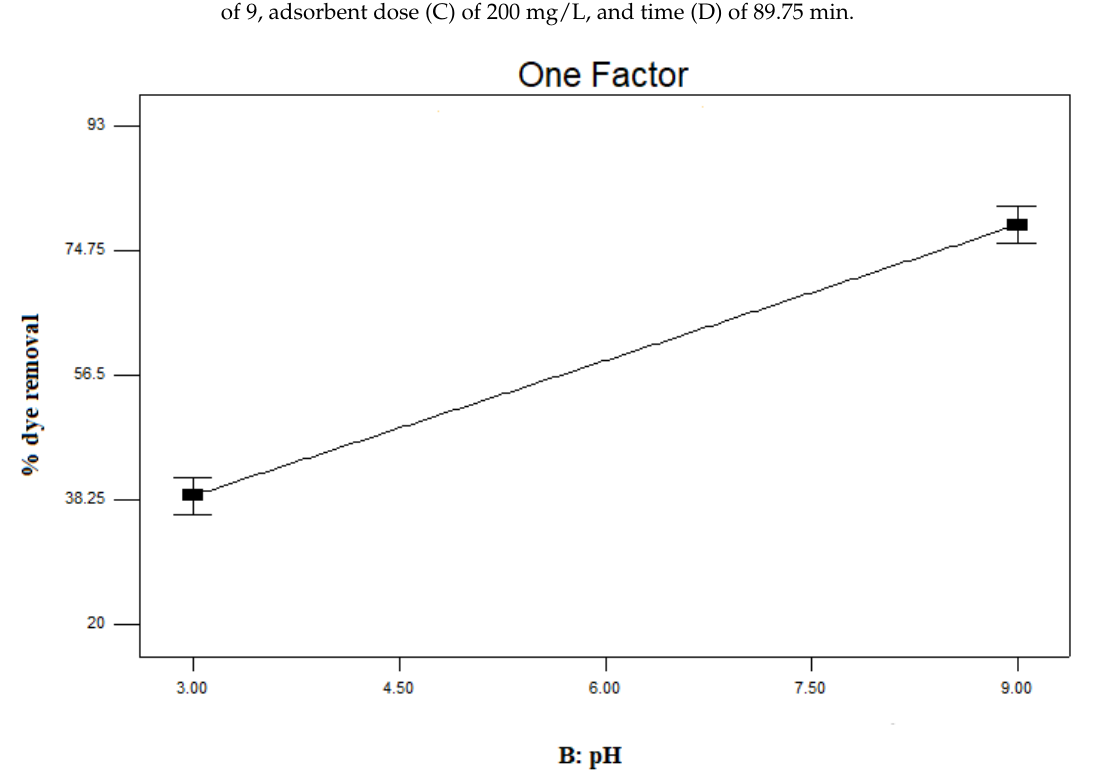
Figure 8. Effect of the solution’s pH on the perecentage dye removal at a constant initial dye concentration (A) of 38.19 mg/L, adsorbent dose (C) of 200 mg/L, and time (D) of 89.75 min.